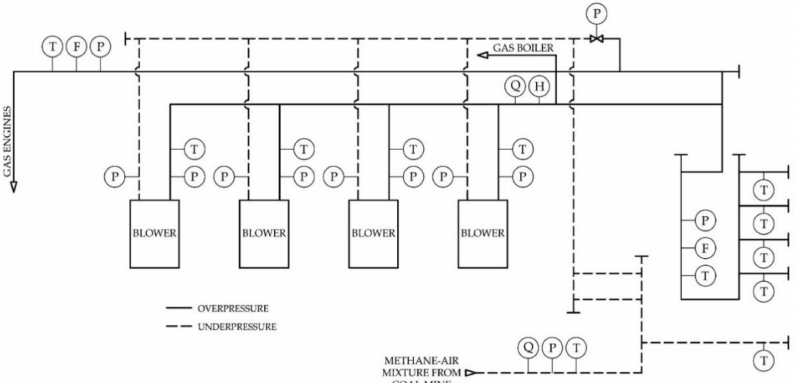
Figure 4. Measurement system for methane utilisation in the Budryk mine with measurement points of gas parameters: P—Pressure; T—Temperature measurement; H—Humidity; Q—Quality;